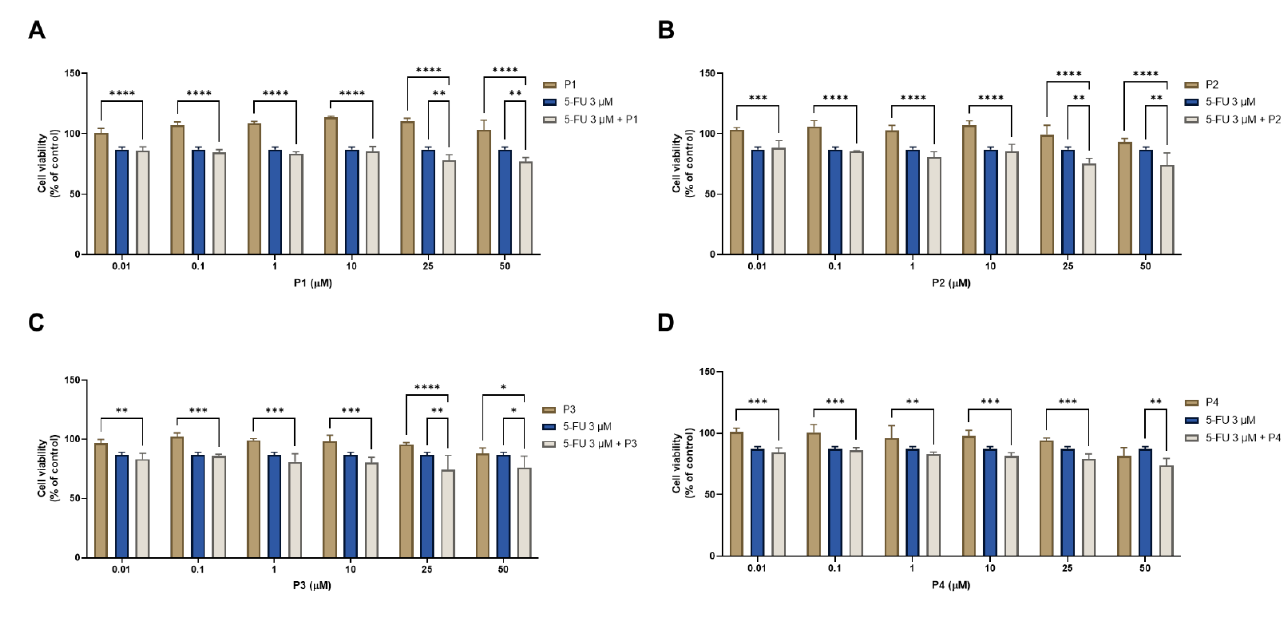
Figure 20. Cytotoxic results of HT-29 after exposure to combinations of 3 µ M of 5-FU with increasing concentrations of the peptides ( A ) P1, ( B ) P2, ( C ) P3, and ( D ) P4 (0.01–50 µ M) for 48 h. Control cells were treated with 0.01% DMSO (vehicle). Cell viability was obtained using the MTT assay, and the results are given as the mean ± SEM ( n = 3). * Statistically significant vs. drug alone at p < 0.05, ** statistically significant vs. drug alone at p < 0.01, *** statistically significant vs. drug alone at p < 0.001, **** statistically significant vs. drug alone at p < 0.0001.